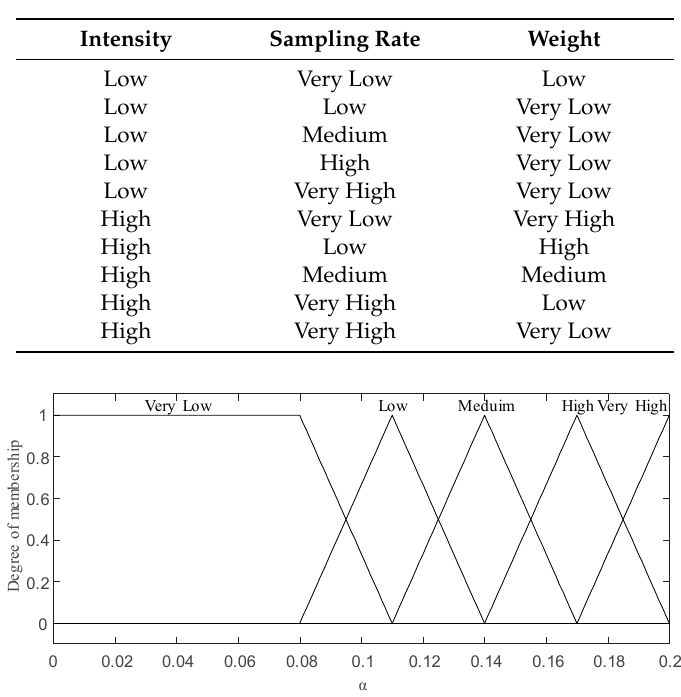
Figure 7. The weight; (VL = Very Low, L = Low, M = Medium, H = High, VH = Very High)